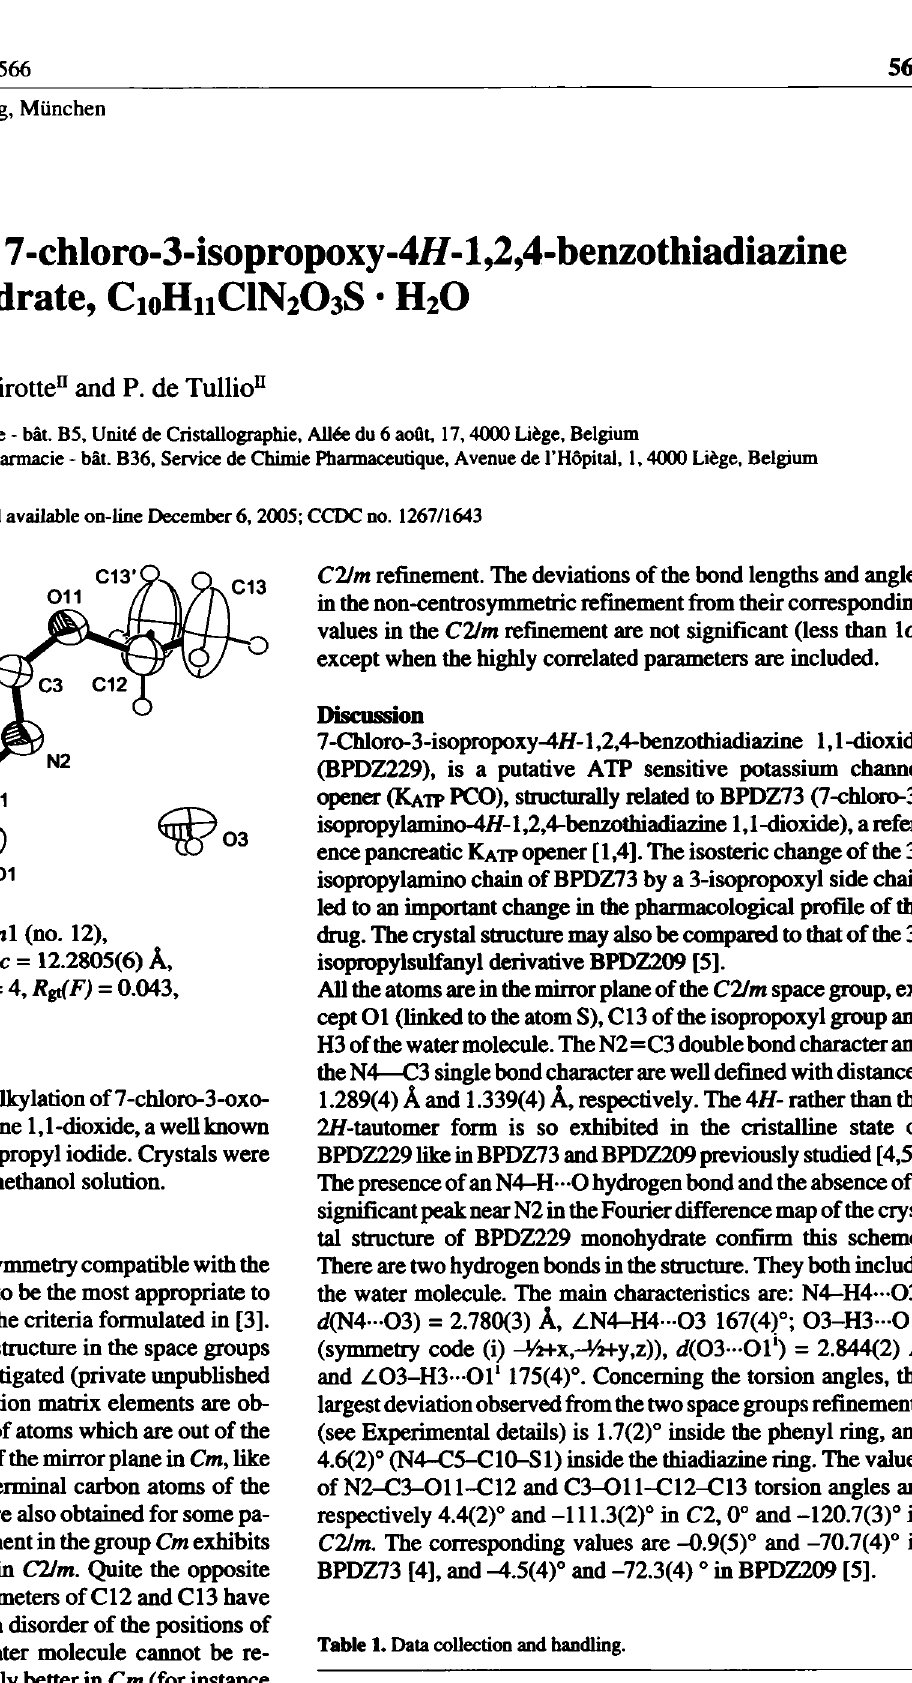
Table 1. Data collection and